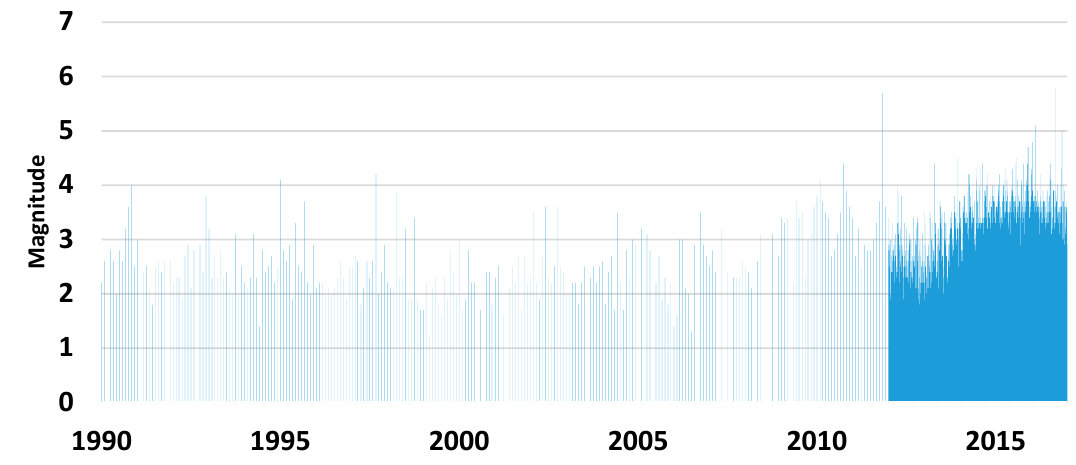
Figure 3. Earthquakes in Oklahoma from 1990 to December 2016 [5].